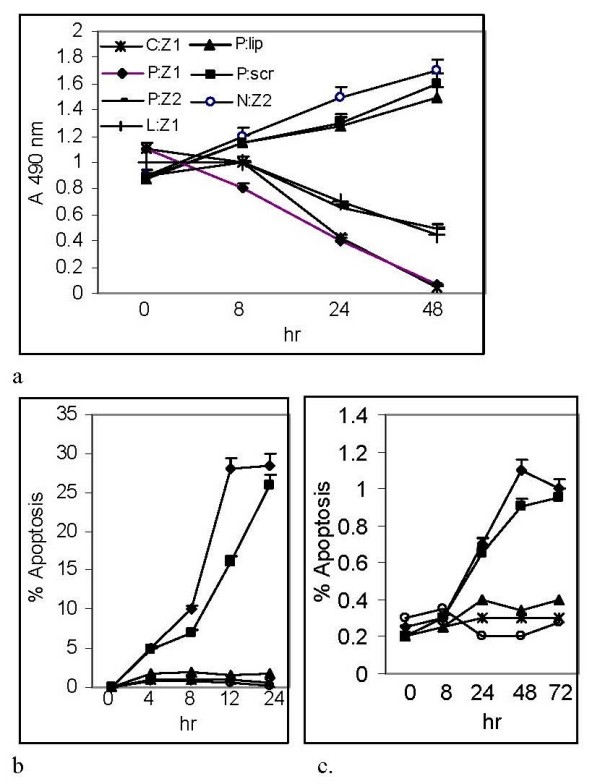
a MTS assays showing that 4 or 6 ug/ml DNAZYM-1P (i.e. Z1 and Z2, respectively) treatment of 90% confluent cultures not only blocked cell growth, but reduced the cell density after 8, 24 and 48 hr, respectively, in (P:Z1, P:Z2) PC-3ML, (L:Z1) LNCaP, and (C:Z1) CPTX-1532 cells. The growth of (N:Z2) NPTX-1532 cells was not blocked by 6 ug/ml DNAZYM-1P treatment after 0, 8, 24 and 48 hr, however. Controls showed that growth of PC-3ML cells treated with lipofectamine (P:lip) or a 6 ug/ml scrambled DNAZYM oligonucleotide (P:scr) was not blocked. 4b-4c. Apoptosis Assays using annexin V antibody labeling and flow cytometry. Showed that 4 & 6 ug/ml DNAZYM-1P (■, ◆) induced increased amounts of apoptosis in (fig. 4b) PC-3 ML cells after 8–24 hr (i.e. 5% to 28%), but failed to induce apoptosis in (fig. 4c) NPTX-1532 cells after 0, 8, 24, 48 and 72 hr treatment (i.e. < 1.2%). Controls showed that (▲) lipofectamine, (○) scrambled DNAZYM oligonucleotide, or (Ж) untreated cells exhibited very low levels of apoptosis.